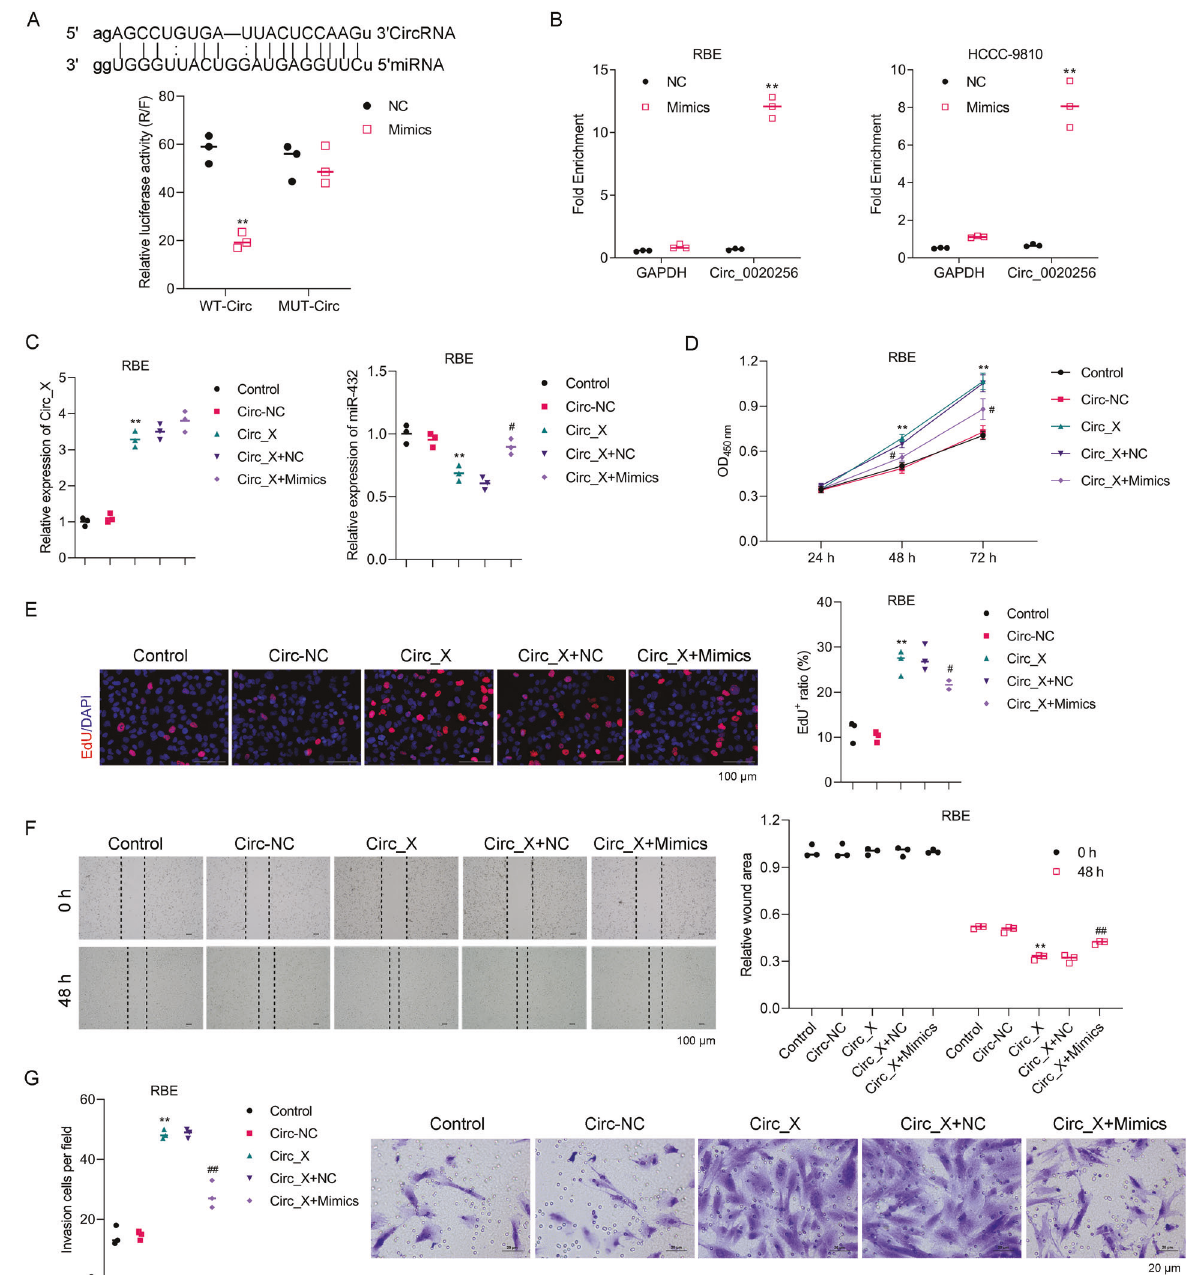
Fig. 5 Hsa_Circ_0020256 enhanced CCA cell proliferation, migration, and invasion via speci fi c miR-432-5p sponging. A The binding sites for hsa_Circ_0020256 on miR-432-5p (upper panel). HEK293T cells were co-transfected with wild-type hsa_Circ_0020256 (WT-Circ) and the NC or miR-432-5p mimics (mimics), or the mutant form of hsa_Circ_0020256 (MUT-Circ) the and NC or miR-432-5p mimics (mimics), and relative luciferase activity was measured. Summary results for luciferase activity assays are shown (lower panel). B The miRNA target IP results from assays performed with HCCC-9810 and RBE cells. C RBE cells were transfected with hsa_Circ_0020256 (Circ_X) or co-transfected with hsa_Circ_0020256 and the NC (Circ + NC) or miR-432-5p mimics (Circ_X + mimics). Hsa_Circ_0020256 and miR-432-5p expression were detected by real-time PCR. D The CCK8 assay results are shown. E The respective images of Edu staining results and a summary of results from three different experiments are shown. F Cell monolayers were wounded and images were acquired at 0 and 48 h. The respective images of Transwell assays are shown. G The results of cell invasion assays as summarized from three independent experiments. * p < 0.05 and ** p < 0.01 compared with the Circ-NC group. # p < 0.05 and ## p < 0.01 compared with the Circ_X + NC group. expressed in CCA tumor tissues and known to be associated with invasion in vitro and progression of CCA in vivo, suggesting that lymph node invasion, an advanced TNM stage, and postoperative TAM-secreted exosomes might be major mediators of crosstalk cancer recurrence [25]. Several other CircRNAs are also dysregu- between TAMs and CCA cells. lated in CCA cells and CCA tumor tissues and are associated with CircRNAs are known to be dysregulated in several types of tumor size and the differentiation grade of CCA [22 – 27]. All the cancer, including CCA [23]. The CircRNA CDR1AS is signi fi cantly